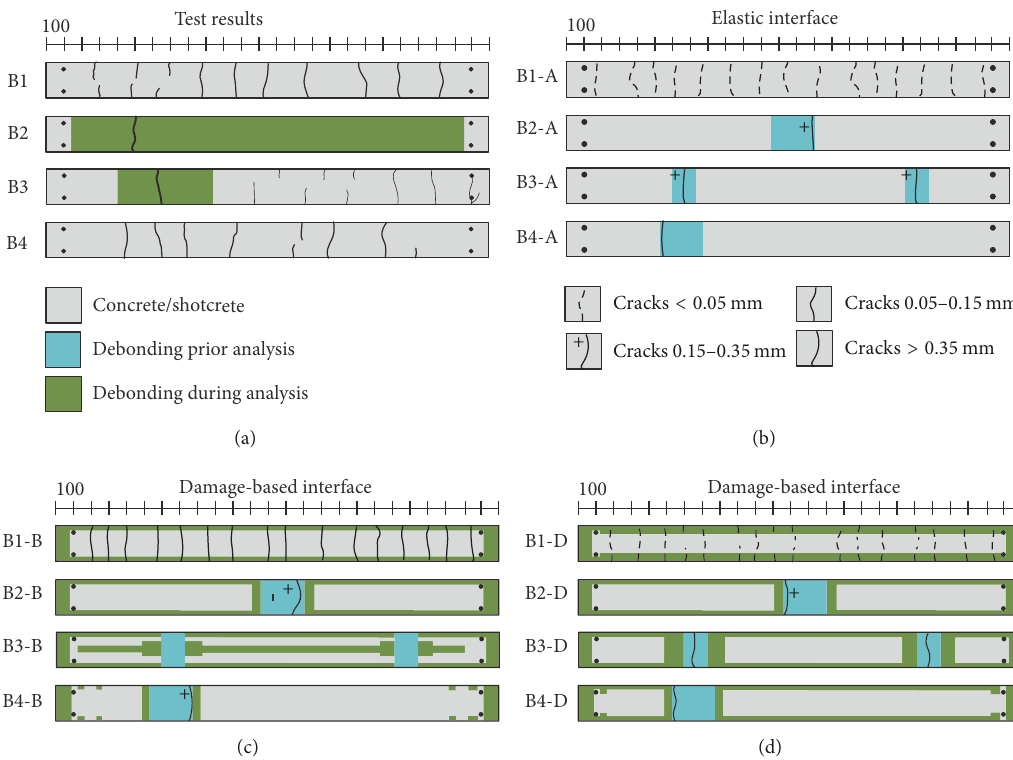
Figure 5: Crack patterns for thin beams B1–B4 cast on concrete slabs, (a) experimental results from [6], (b) numerical simulations with elastic interaction, (c) numerical simulations with 𝐺 𝑓 = 125 Nm, and (d) numerical simulations with 𝐺 𝑓 = 10 Nm. Measurements in